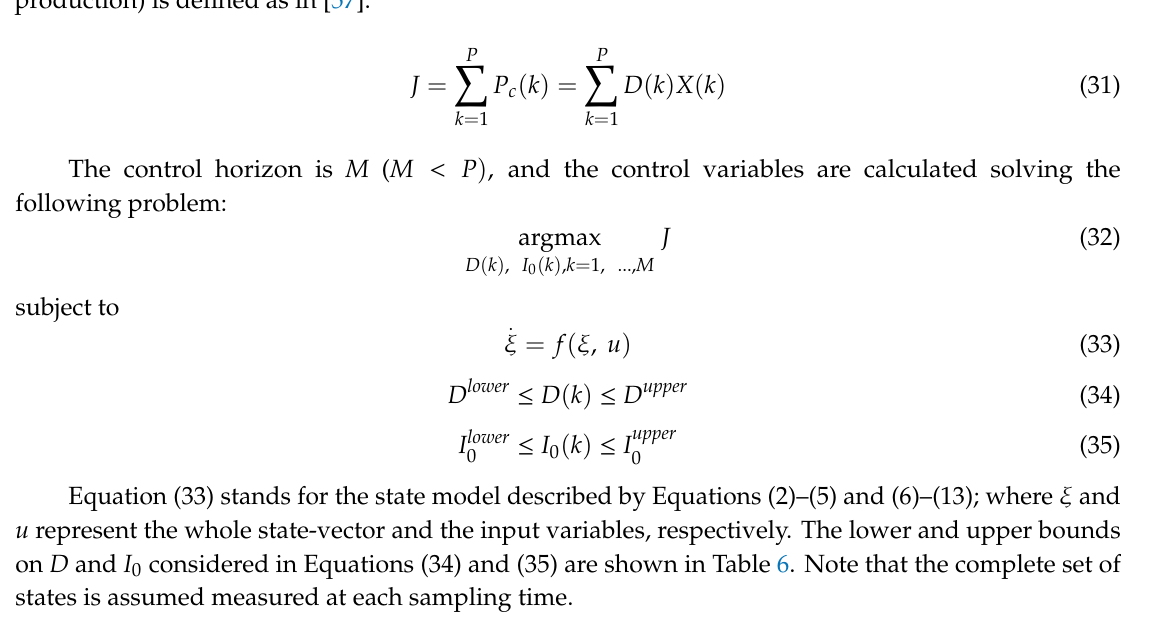
Table 6. Manipulated variables